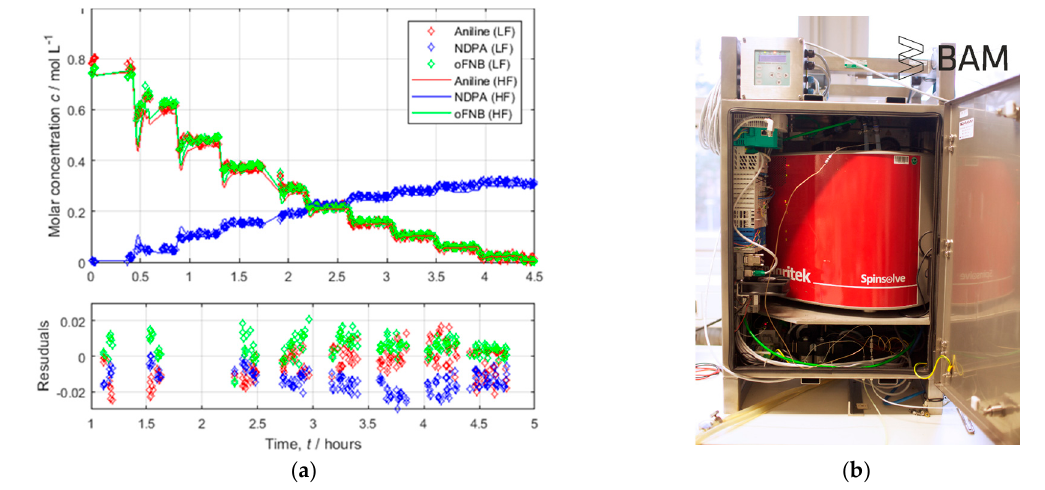
Figure 2. Smart NMR sensor module: ( a ) Monitoring of the aromatic coupling of 1-Fluoro-2- nitrobenzene (FNB) with aniline to 2-Nitrodiphenylamine (NDPA) using Lithium-bis(trimethylsilyl) amide (Li-HMDS) in semi batch operation. Online 43.5 MHz low-field NMR (LF) was compared to 500 MHz high-field NMR spectroscopy (HF) as reference method. Mole fractions are plotted versus time, observed deviations are below 20 mmol/L over the whole working range; ( b ) 43.5 MHz benchtop online NMR sensor in an explosion proof housing (EX II 2G Ex pxb db ib IIB T3 Gb) of 57 × 57 × 85 cm module